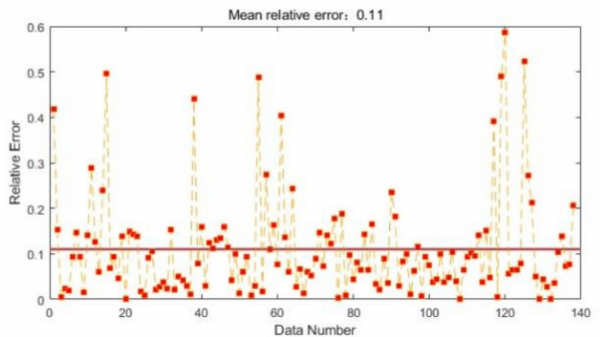
Figure 13. Relative error of RBF neural networks. The red line represents the mean relative error.